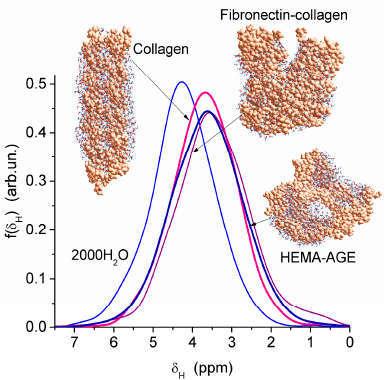
Figure 7. Theoretical 1 H NMR spectra of water bound to models of partially hydrated gels with cross-linked HEMA-AGE (2373 atoms) with 1192 H 2 O, collagen (two triple coils (1639 atoms) and 1032 H 2 O) and fibronectin (8–9 Fn)—collagen (3200 atoms) with 827 H 2 O (geometry optimized with PM6 method).